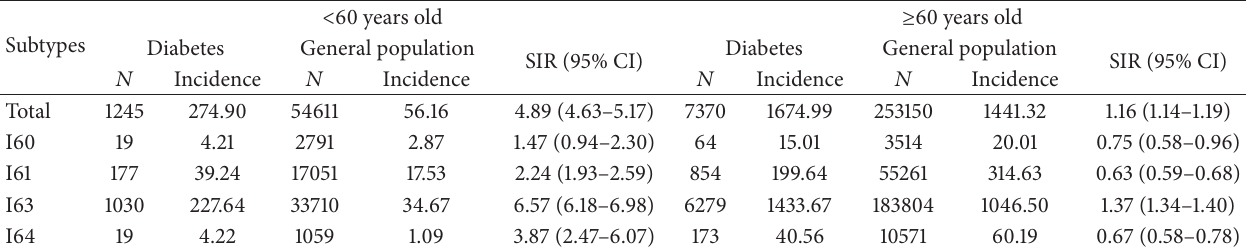
Table 4: SIRs in age at diagnosis of T2DM compared with general population, 2007–2013 (1/100,000